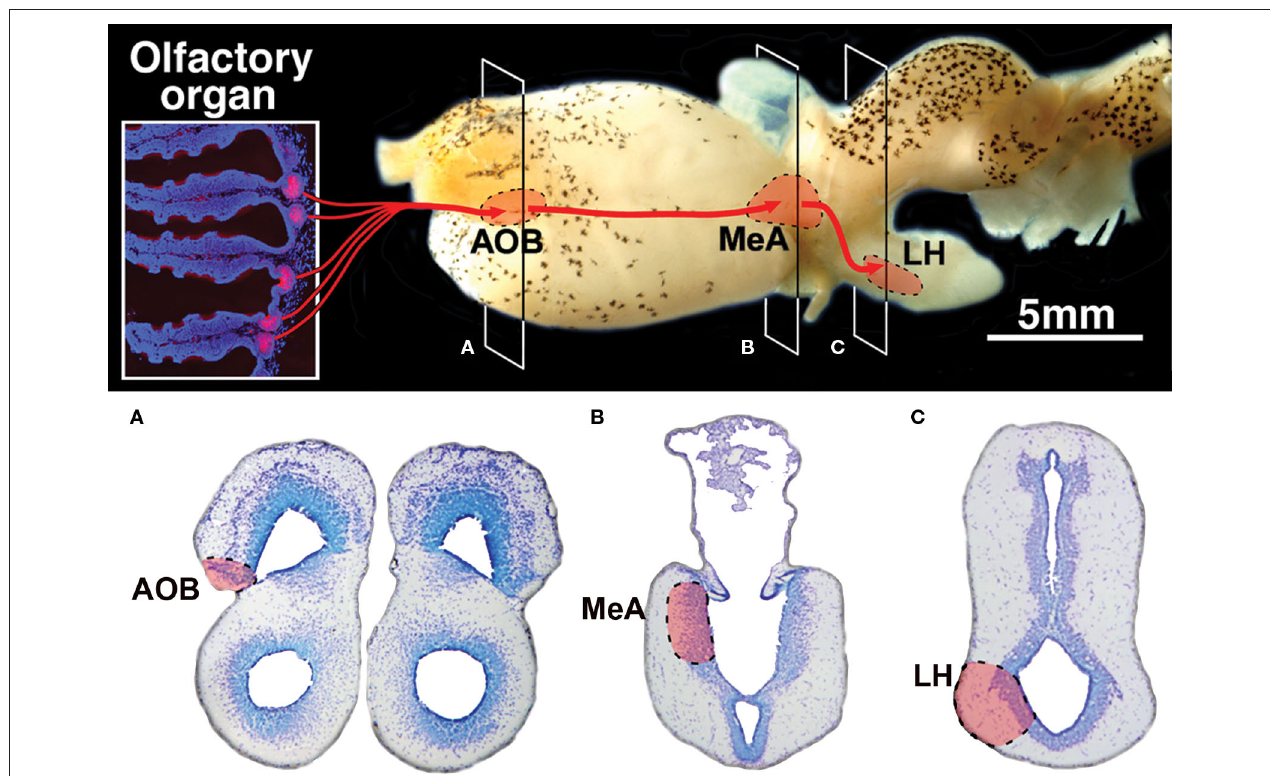
Figure 7 | Summary diagram of the vomeronasal system in lungfishes. (A–C) Transverse Nissl stained sections at the levels indicated on the lateral view of the brain showing the location of its three relay centers in the accessory olfactory bulb (AOB), the medial amygdala (MeA) and the lateral hypothalamus